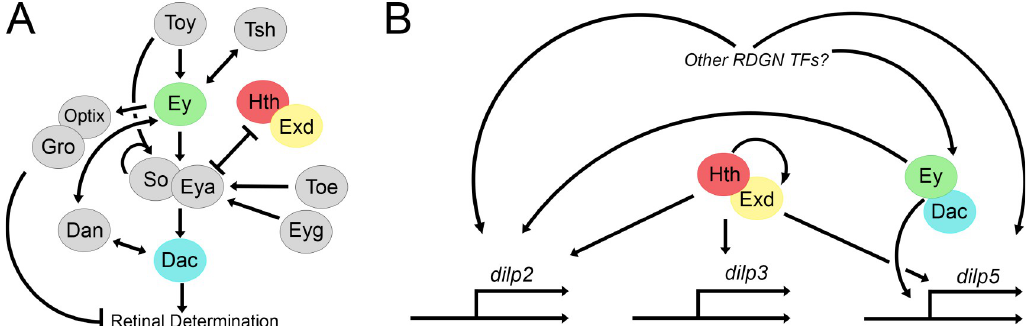
Fig 8. A reshuffled RDGN regulates dilp expression in the IPCs. (A) Schematic showing the regulatory relationships of the RDGN in the developing eye (modified from Kumar [33] and Bu¨rgy-Roukala et al . [62] ) .(B) Speculative model of the RDGN in dilp regulation. Hth and Exd as a pair directly or indirectly regulate dilp2 , -3 and -5 expression, while Ey and Dac directly regulate dilp5 epxression [32] and via other factors dilp2 and dilp3 . Other RDGN TFs directly or indirectly regulate dilp2 and dilp5 expression